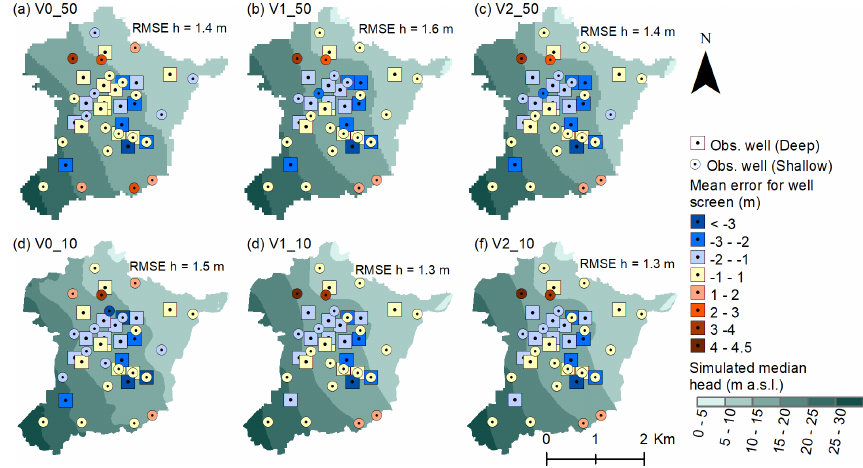
Figure 9. Mean error in the simulated hydraulic head, where the circle signature represents the shallow well screens and the square signature represents the deep well screens. The background map shows the median simulated head.